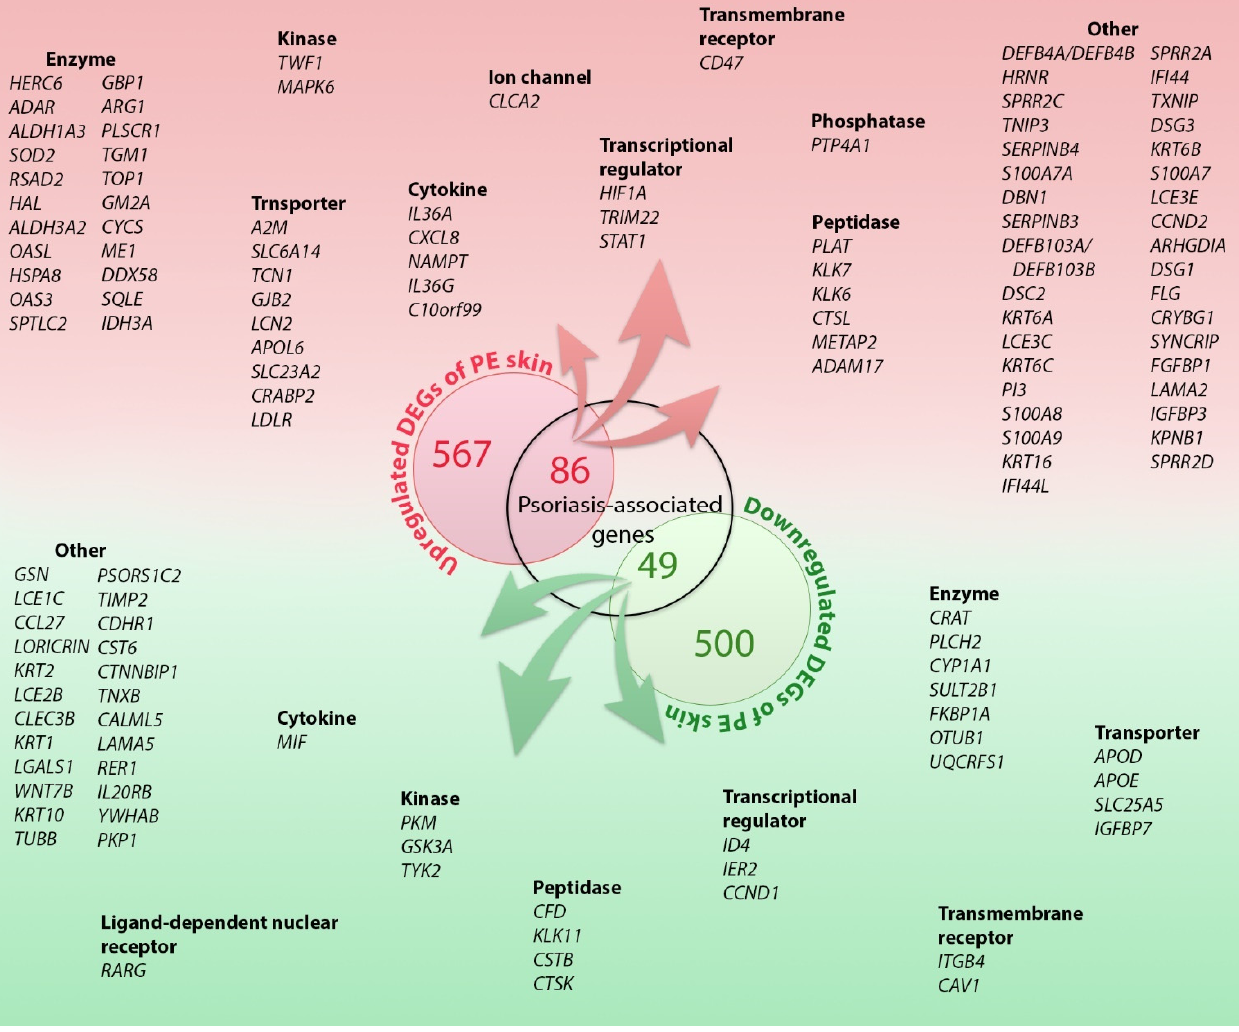
Figure 1. The differentially expressed genes (DEGs). A total of l202 genes was identified as the DEGs in the peripheral edge of the lesional (PE) skin vs. uninvolved (UN) skin. Of these, 653 (54%) were upregulated and 549 (46%) were downregulated. Among these DEGs, 135 DEGs are overlapped with previously reported psoriasis-associated genes or proteins. Red presents upregulation in the PE skin and green represents downregulation in the PE skin. Proteins of the 86 upregulated DEGs might be potential molecules involved in psoriasis pathogenesis in the PE skin. The DEGs are listed based on their molecule